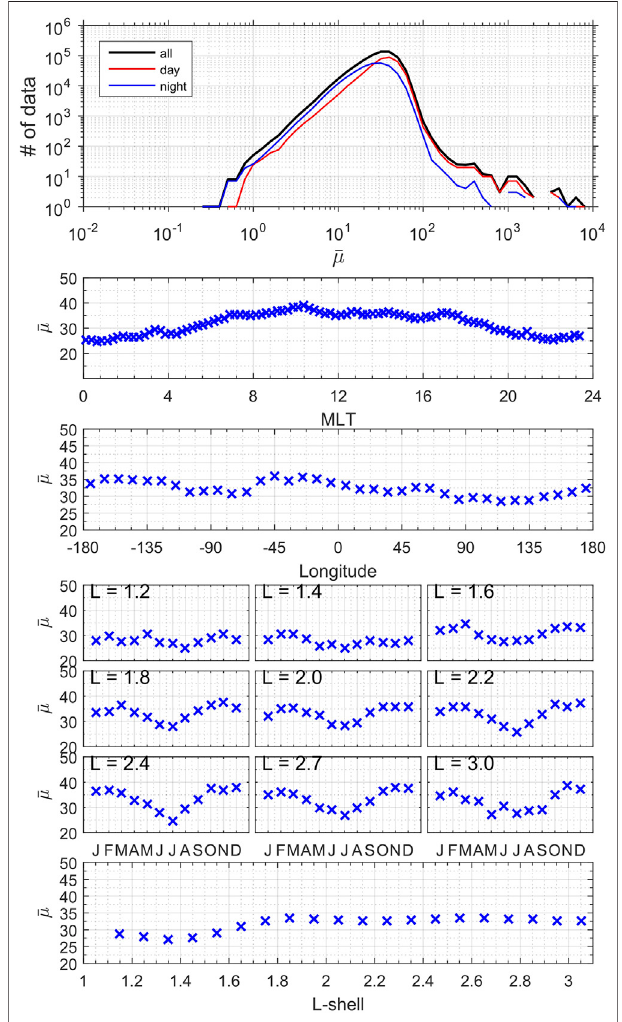
FIGURE 10 | ( fi rst panel) Distributions of the refractive index (µ) at (red) day, (blue) night, (black) all times. Refractive index is plotted versus (second panel) MLT and (third panel) longitude (fourth panel) Monthly and ( fi fth panel) total average of wave normal angle versus